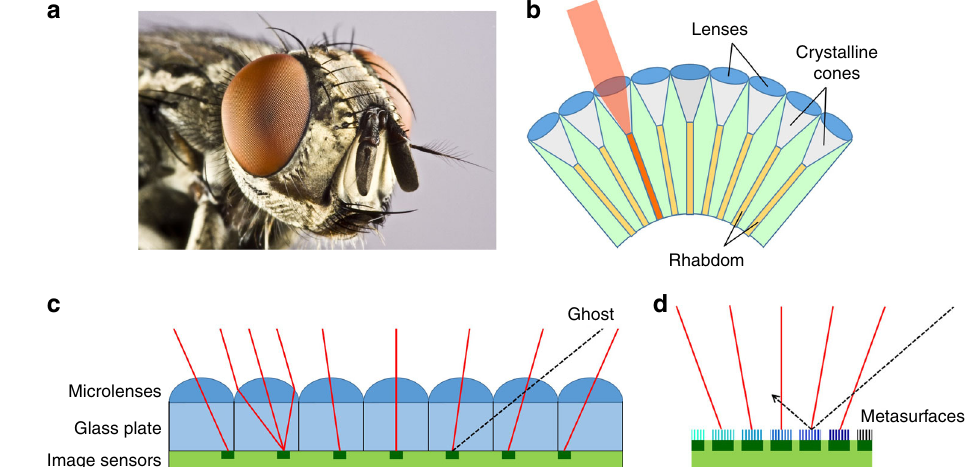
Fig. 1 Compound eyes. a Micrograph of the compound eyes of a horse fl y. Used with permission (copyright: Michael Biehler/123RF.COM). b Schematic illustration of the apposition compound-eye architecture. c Arti fi cial compound-eye camera based on a planar microlens array and a photodetector array separated by a glass plate. By design the two arrays have different periodicities, so that each sensor detects light incident along a different direction. d Compound-eye camera based on the angle-sensitive metasurfaces developed in the present work, where only light incident along a different direction is transmitted into each image